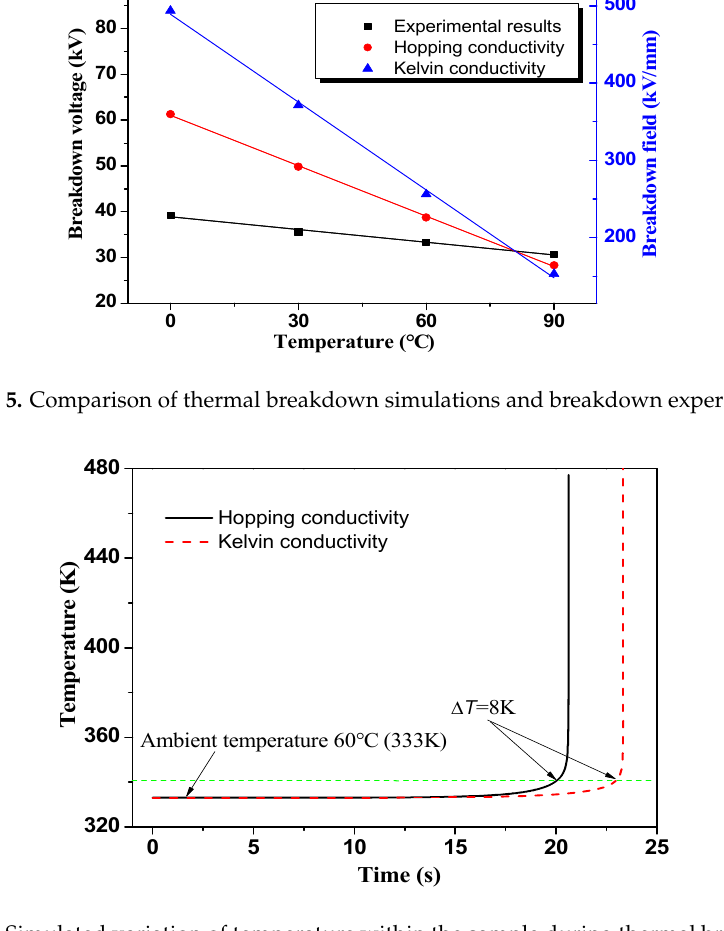
Figure 6. Simulated variation of temperature within the sample during thermal breakdown.